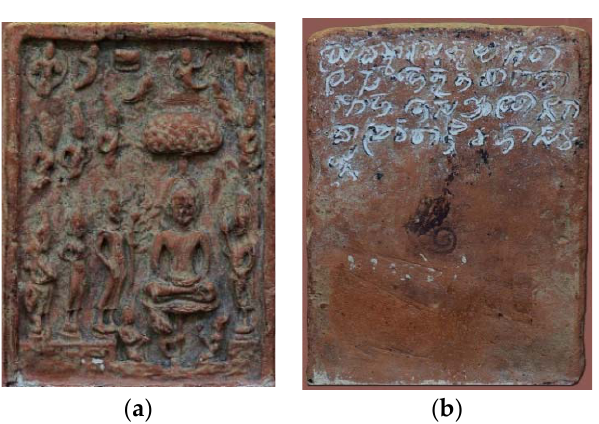
Figure 4. The Ś r ā vast ī miracles (Buddha meditating beneath a blooming tree and the n ā ga ) with ye Figure 4. The Śrāvastī miracles (Buddha meditating beneath a blooming tree and the nāga ) with dhamm ā formula. Ca. 7th ‐ 9th centuries CE. Moulded tablet, clay. Songkhla National Museum. ( a ) ye dhammā formula. Ca. 7th–9th centuries CE. Moulded tablet, clay. Songkhla National Museum. Font Side; ( b ) back Side. After Revire (2014, fig. 15a,b). ( a ) Font Side; ( b ) back Side. After Revire (2014, fig.